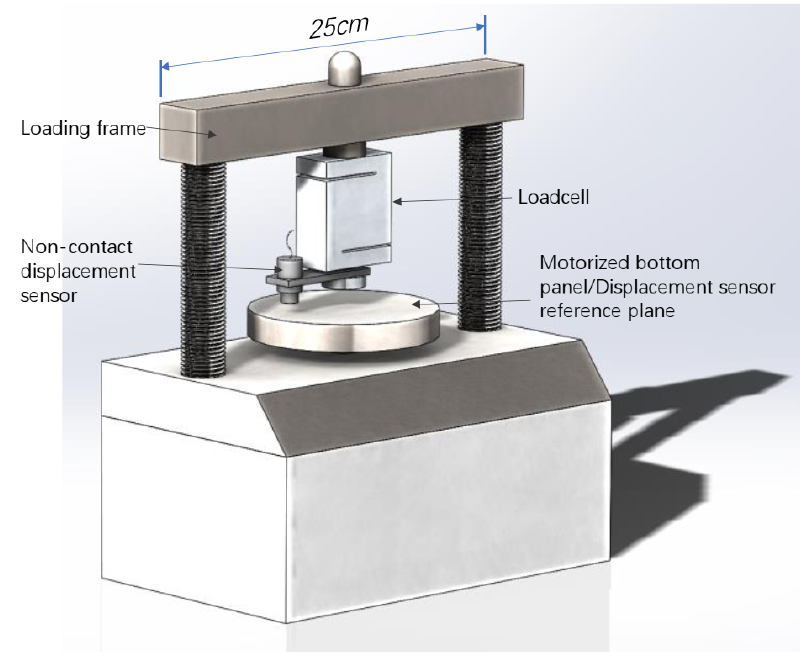
Figure 2. Schematic illustration of the testing